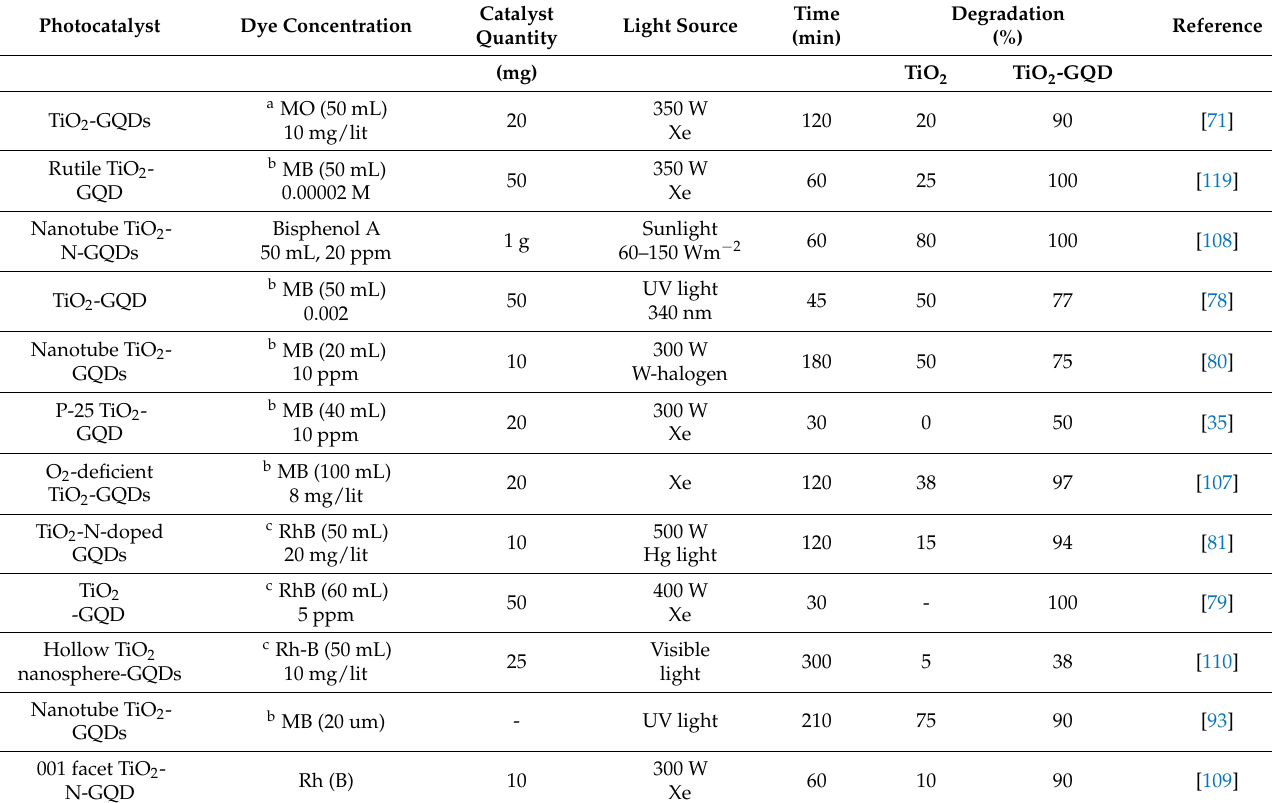
* The data in the table represent the best results obtained in the reference. a = Methyl orange, b = Methylene blue and c = Rhodamine